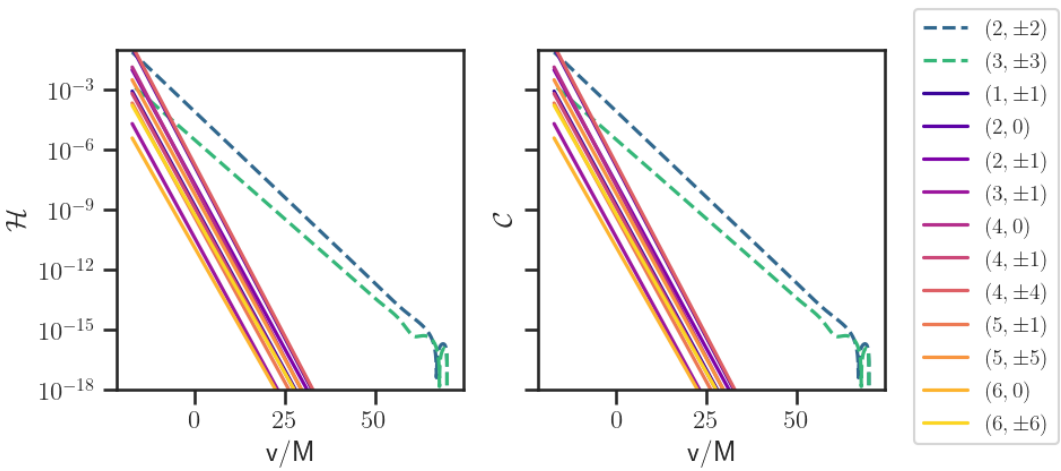
Figure 4 . Modes evolution i the dynamical variables H = h + (cid:15)H (left) and C = c + (cid:15)C (right). The dashed lines correspond to the modes that are directly excited by the source ( (2 , ± 2) and (3 , ± 3) ) whereas the solid lines correspond to modes excited to second-order. The perturbative scale is (cid:15) = 10 − 12 in this case.